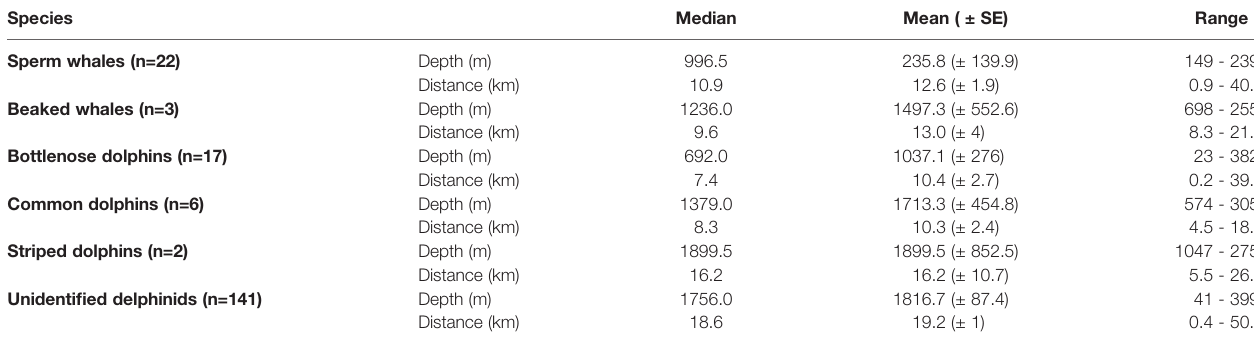
TABLE 2 | Summary of depths and distances from the nearest shore of deep diving cetaceans and delphinid species in the study area. Species